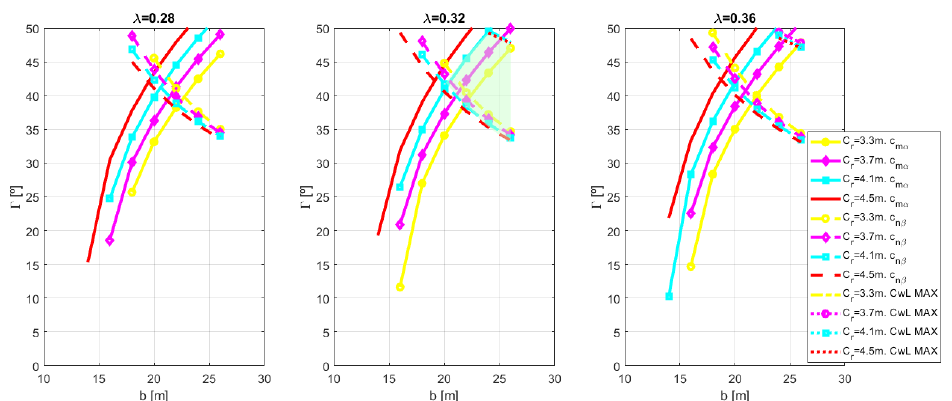
Figure 4. Feasible design space defined by the constraints imposed by static derivatives at cruising conditions, both longitudinal ( c m α ) and lateral ( c n β ), and by the maximum deflection of the lateral control for crosswind landing conditions, establishing a maximum value for the dihedral angle (CwL